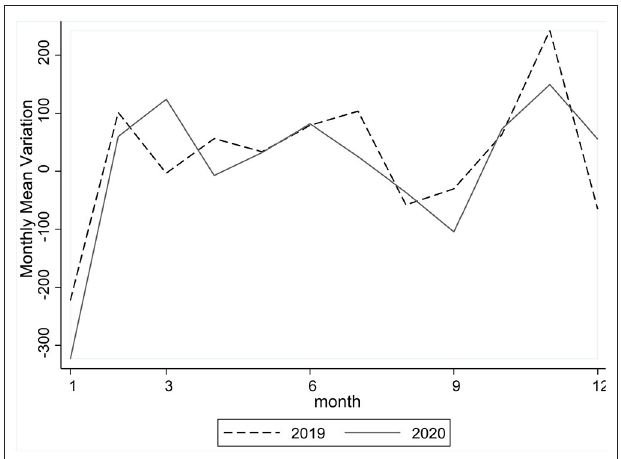
FIGURE 2 | Monthly mean variations in CO 2 emissions between 2019 and